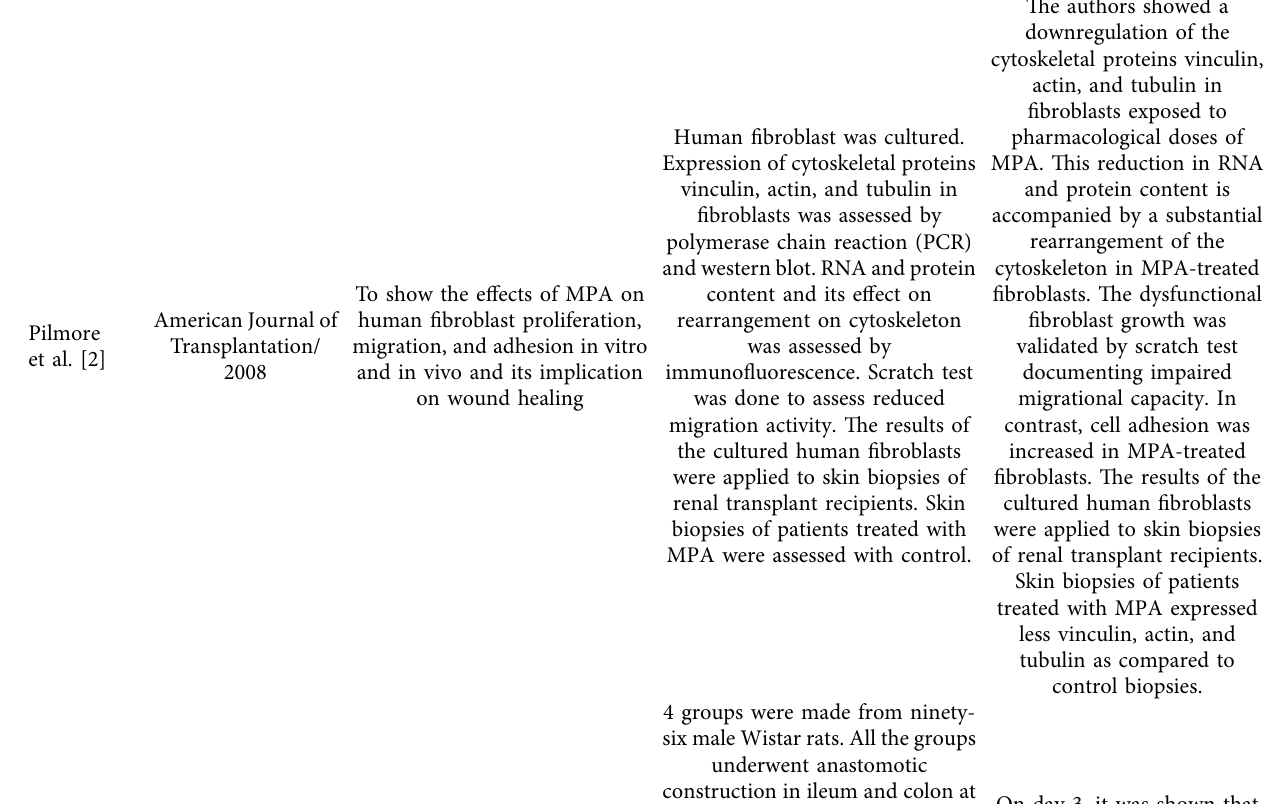
Table 2: Experimental and clinical studies performed on mycophenolic acid derivatives and their effects on wound healings.